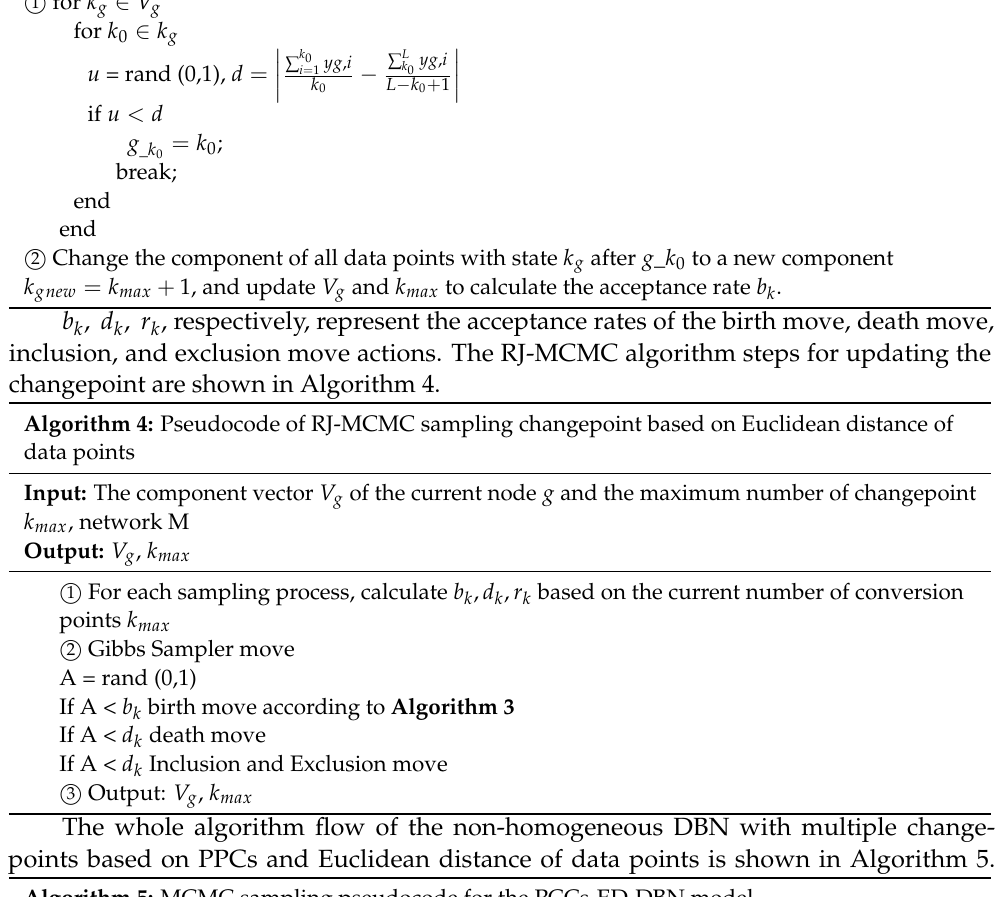
Algorithm 5: MCMC sampling pseudocode for the PCCs-ED-DBN